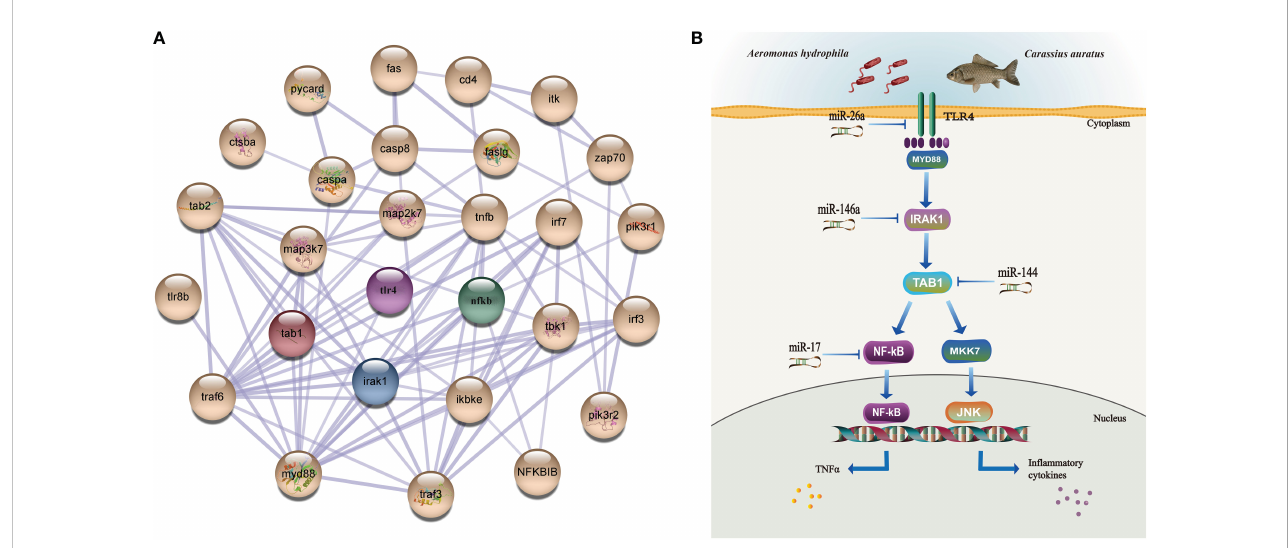
FIGURE 10 Interaction network analysis and illustration of the regulation mechanisms of the key miRNAs/target genes in the gills of Carassius auratus infected with Aeromonas hydrophila . (A) Interaction analysis of the protein – protein interaction (PPI) networks. Different colored balls represent the differentially expressed proteins (DEPs), the node indicates representative proteins of the corresponding pathway, and the line thickness denotes the strength of the predicted functional interactions. (B) Illustration of the regulation mechanism of the key miRNAs/target genes in the gills. miR-26a, miR-146a, miR-144, and miR-17 were identi fi ed in the gills, which were involved in the local immune regulation of the Toll-like receptor (TLR), mitogen-activated protein kinase (MAPK), and nuclear factor kappa B (NF- k B) signaling pathways by targeting Toll-like receptor 4 ( TLR4 ), interleukin-1 receptor-associated kinase 1 ( IRAK1 ), TGF-beta-activated kinase 1 and MAP3K7-binding protein 1 ( TAB1 ), and nuclear factor kappa-B kinase subunit alpha-like ( NF- k B